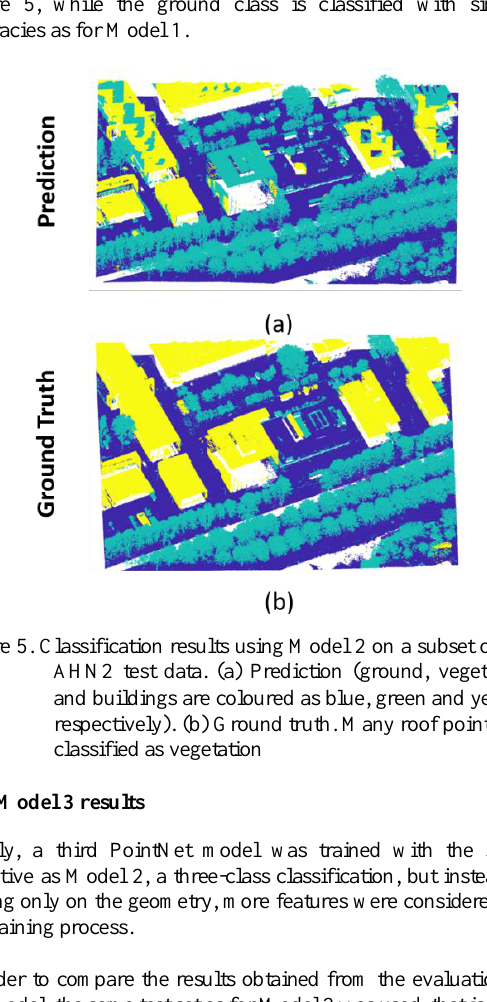
Table 6. Model 3 results.